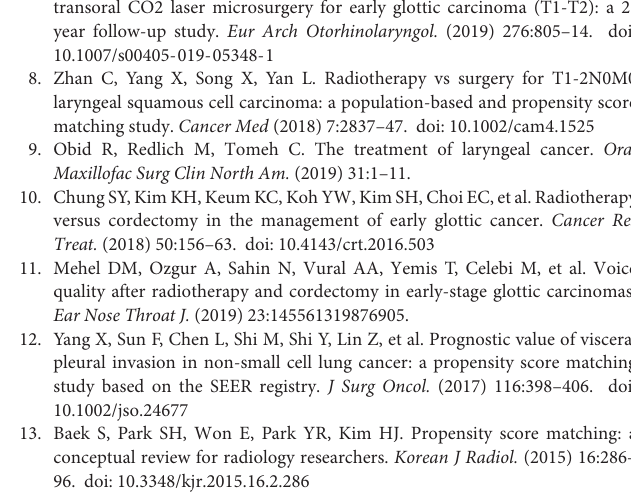
FIGURE S1 | Survival analyses for patients with radiotherapy and with surgery stratified by age after matching (A) ≤ 50 years of age. (B) 51–60 years of age. (C) 61–70 years of age. (D) 71–80 years of age. (E) > 80 years of age. FIGURE S2 | Survival analyses for patients with radiotherapy and with surgery stratified by race. (A) White. (B) Black. (C) Other race. FIGURE S3 | Survival analyses for patients with radiotherapy and with surgery stratified by sex. (A) Male. (B) Female. FIGURE S4 | Survival analyses for patients with radiotherapy and with surgery stratified by differentiation after matching (A) Well differentiated. (B) Moderately differentiated. (C) Poorly or undifferentiated, anaplastic. (D) Differentiation unknown. FIGURE S5 | Survival analyses for patients with radiotherapy and with surgery stratified by stage. (A) Stage I. (B) Stage II. FIGURE S6 | Survival analyses for patients with radiotherapy and with surgery stratified by T stage after matching (A) T1a. (B) T1b. (C) T1NOS. (D) T2. FIGURE S7 | Survival analyses for patients with radiotherapy and with surgery stratified by insurance. (A) Patient who had insurance. (B) Patients at other insurance status. FIGURE S8 | Survival analyses for patients with radiotherapy and with surgery stratified by marital status. (A) Married patient. (B) Patients at other marital status. TABLE S1 | Characteristics of year at diagnosis of patients according to the therapy status before and after propensity score matching. TABLE S2 | Results of year at diagnosis in univariate and multivariate analyses of cancer-specific survival after